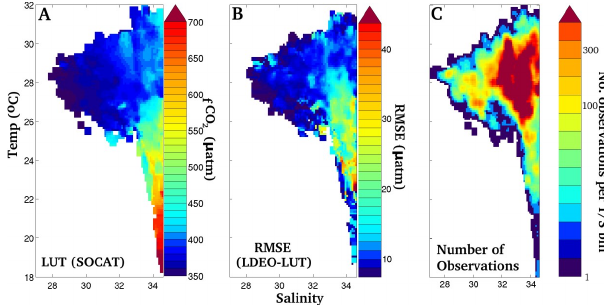
Figure 5. (a) The look-up table derived from the position of ETPO SOCAT f CO 2 measurements within T S space. (b) The root-mean- square error of the LUT– f CO 2 observations, showing the vari- ance between f CO 2 observed within the same T S space in the LUT. (c) The number of LDEO measurements per 0.1 ◦ × 0.1 ◦ salin- ity/temperature bins that went into generating the